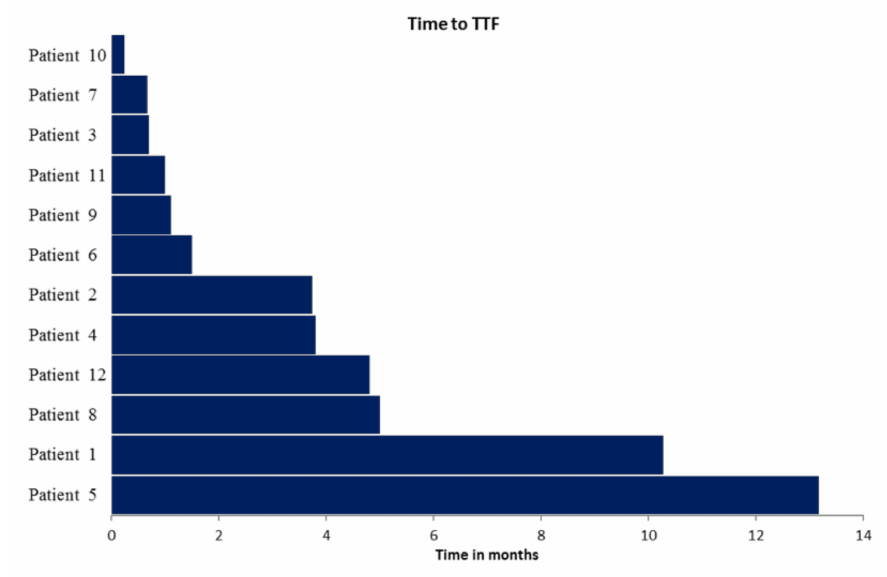
Figure 2. Time to treatment failure (TTF) in the 12 patients who received PTB recommended treatment. Respective patient characteristics and targeted treatment are depicted in Table